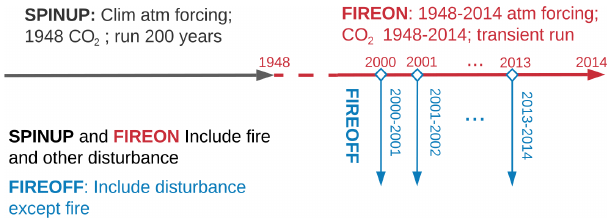
Figure 3. Experiment design for fire effects in SAF (0–37 ◦ S; 0– 50 ◦